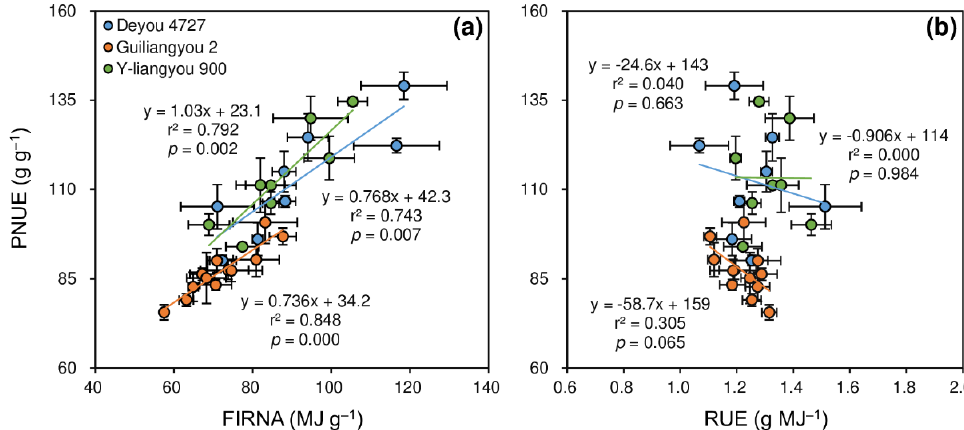
Figure 1. Relationships between physiological N use efficiency (PNUE) and ( a ) the fraction of canopy-intercepted radiation to plant N absorption (FIRNA) and ( b ) radiation use efficiency (RUE) in three widely grown, high-yielding rice varieties (i.e., Deyou 4727, Guiliangyou 2, and Y-liangyou 900).